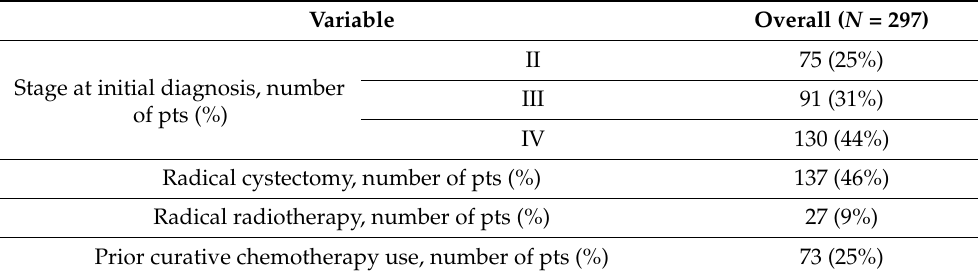
Table 2. Survival outcomes in patients receiving palliative therapies, calculated from date of me- tastasis.